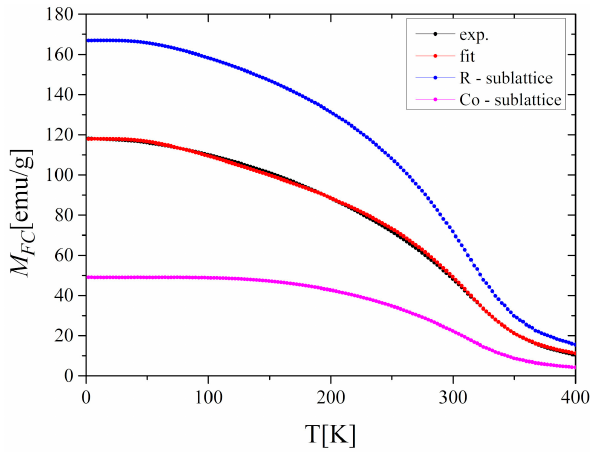
µ = 5 T and the results of MFT analysis for the Gd 0 H